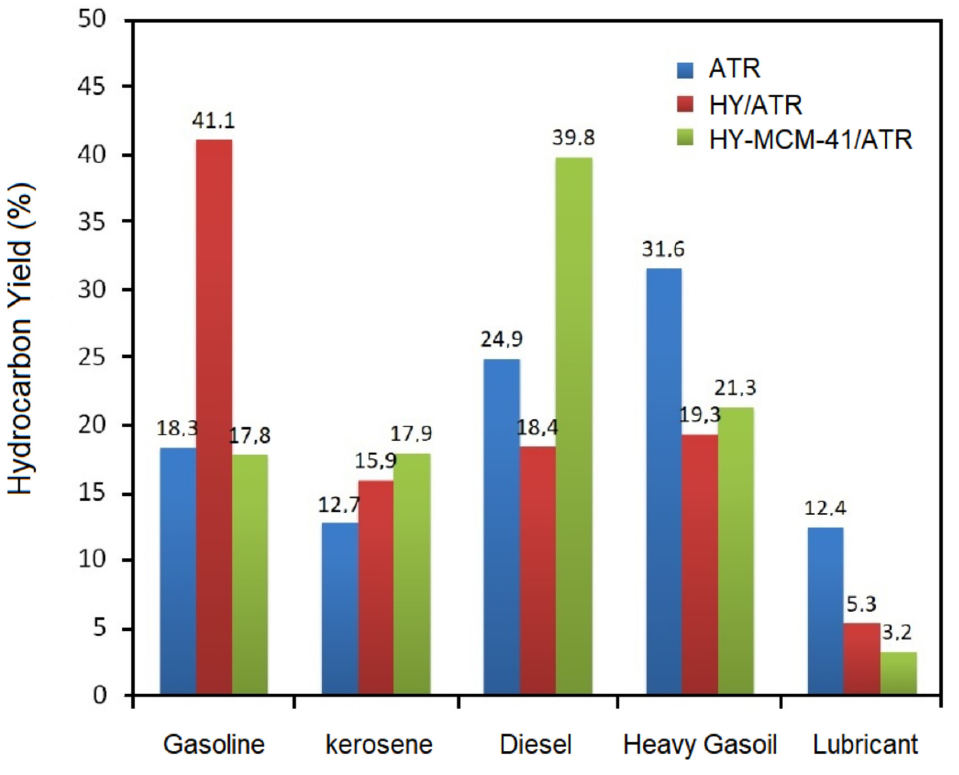
Figure 5. Hydrocarbon distribution obtained from the distillation of pure ATR and in presence of HY and hybrid HY-MCM-41 catalysts.